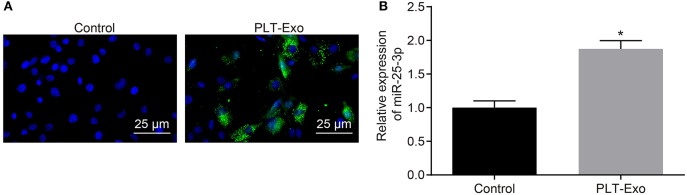
CVECs endocytose PLT-Exo to elevate miR-25-3p expression. (A) Fluorescence staining results of PKH67-labeled PLT-Exo co-cultured with CVECs (Scale bar = 25 μM). (B) MiR-25-3p expression in CVECs treated with PLT-Exo, as determined by RT-qPCR. *p < 0.05 vs. the control group (CVECs without any treatment). The measurement data are expressed as mean ± standard deviation and comparisons between two groups were analyzed using independent sample t-test. The experiment was repeated three times independently.